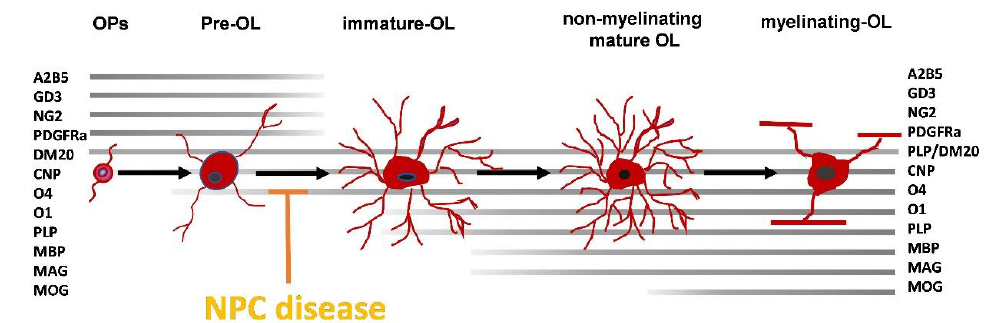
Figure 1. Blocking of oligodendrocyte differentiation in the NPC. Specific markers allow identifying the differentiation status of cells of the oligodendrocyte lineage from progenitors (OPs) to myelinating OLs. The stage when the maturational block due to NPC mutation occurs is indicated. The markers indicated are: A2B5 and GD3 antigens, cell surface gangli- osides; NG2, cell surface chondroitin sulfate proteoglycan; PDGFRα, platelet-derived growth factor receptor alpha; DM20, a splice variant of the proteolipid protein; CNP, 2′,3′-Cyclic-nucleotide 3′-phosphodiesterase; O 4 antigen, cell surface sulfatide; O 1 , galactocerebroside; PLP: proteolipid protein; MBP, myelin basic protein; MAG, myelin- associated glycoprotein; MOG, myelin oligodendrocyte protein.